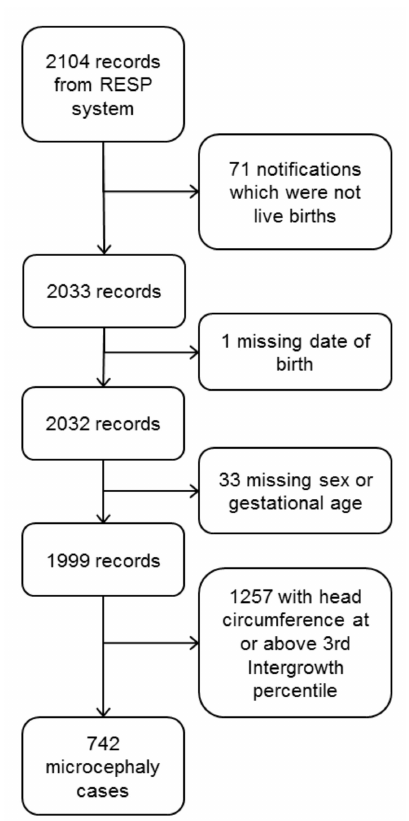
Figure 2. Flowchart of the inclusion of birth records from the Registro de Eventos em Sa ú de P ú blica (RESP) system.